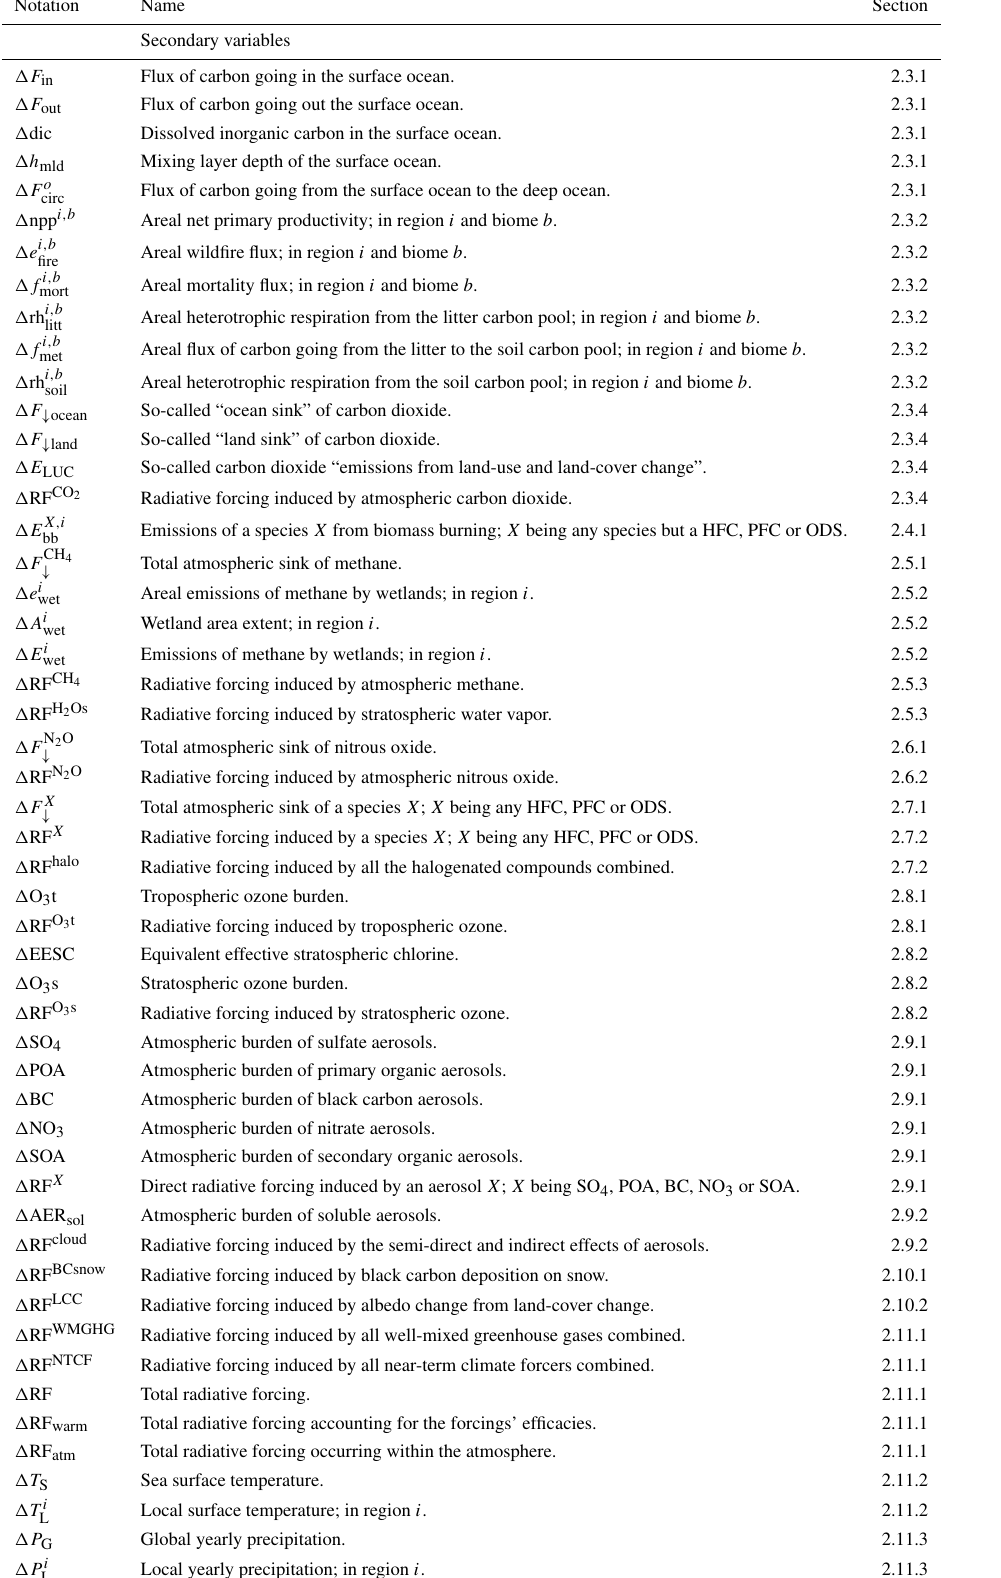
Table 2. List of secondary variables of the